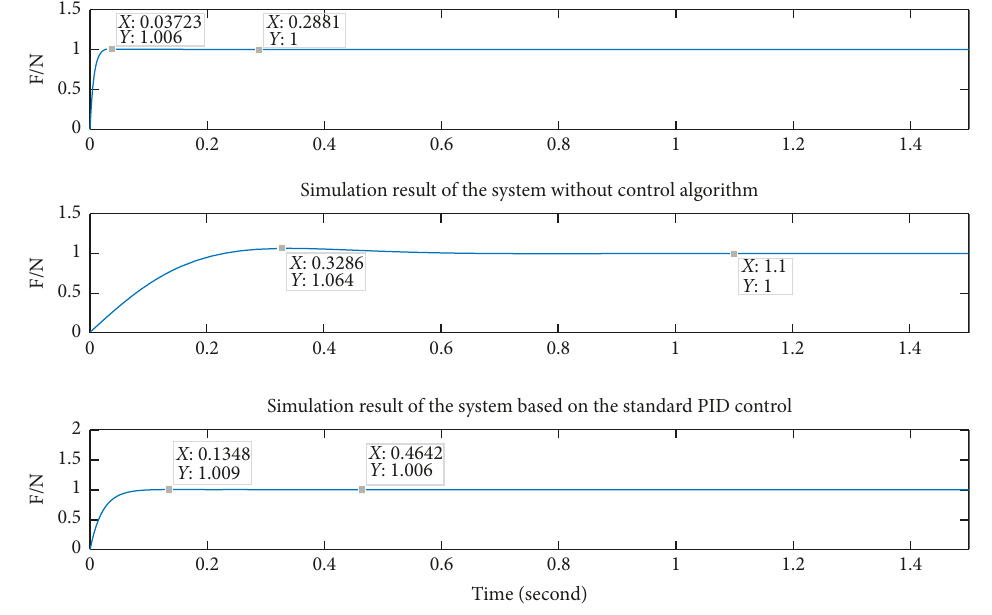
Figure 14: The simulation results of the systems.